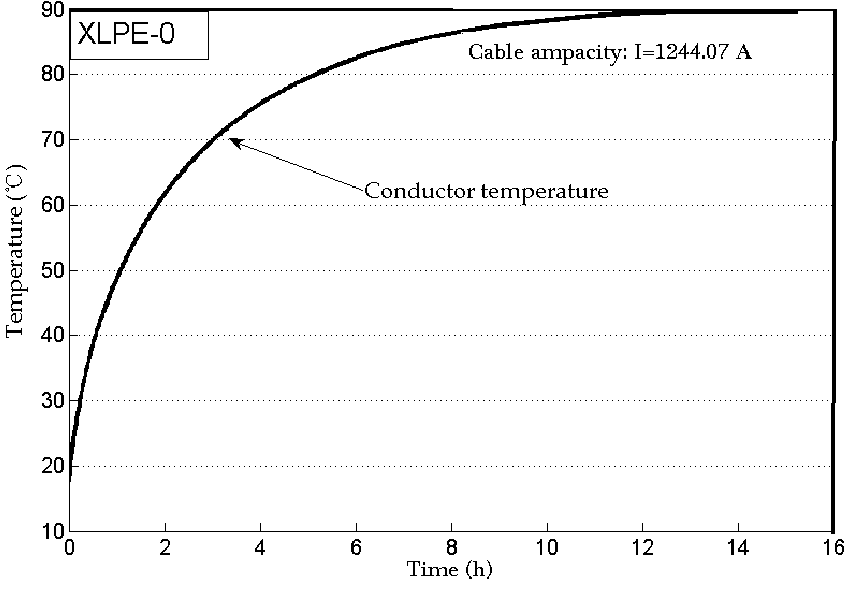
Figure A1. The calculating result of the XLPE-0 cable ampacity.